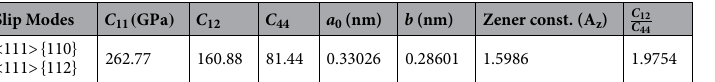
Table 6. Parameters used in the calculation of the contrast factor and dislocation character as required in eCMWP.